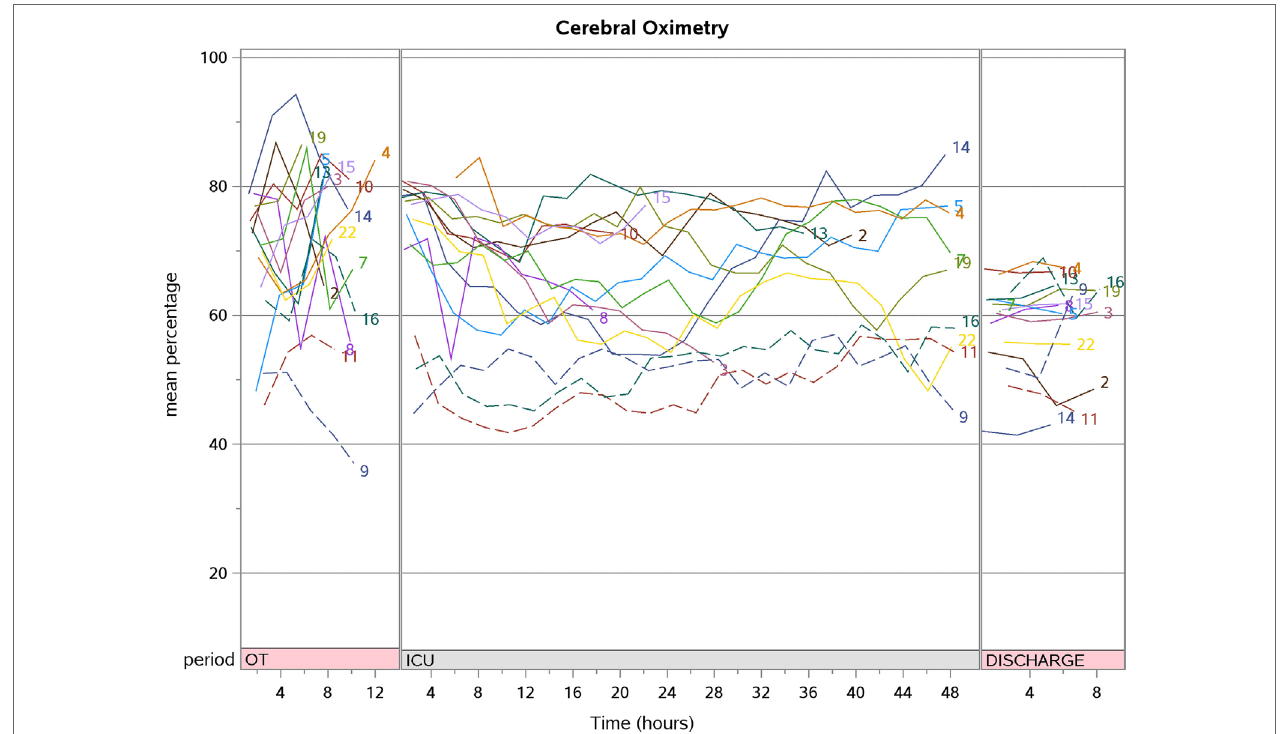
FigUre 2 | The aggregate cerebral oximetry trend for patients who underwent corrective surgery ( N = 15).